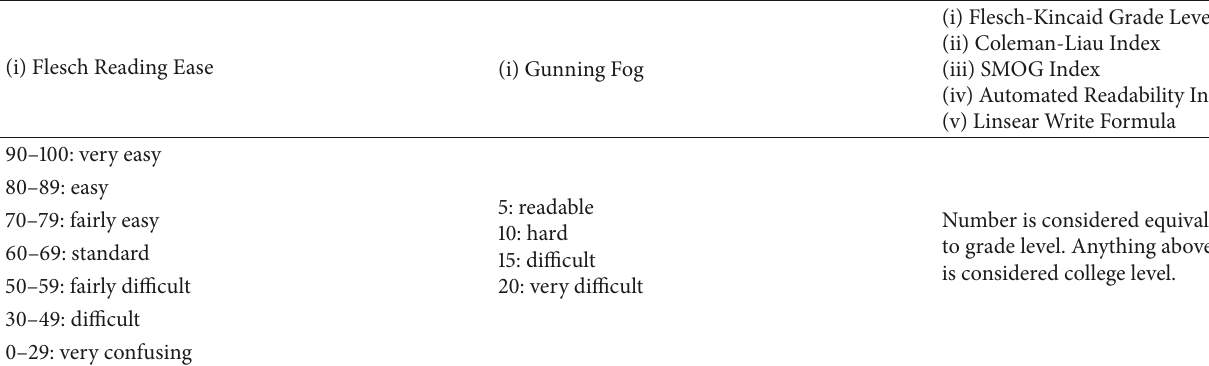
Table 1: Readability